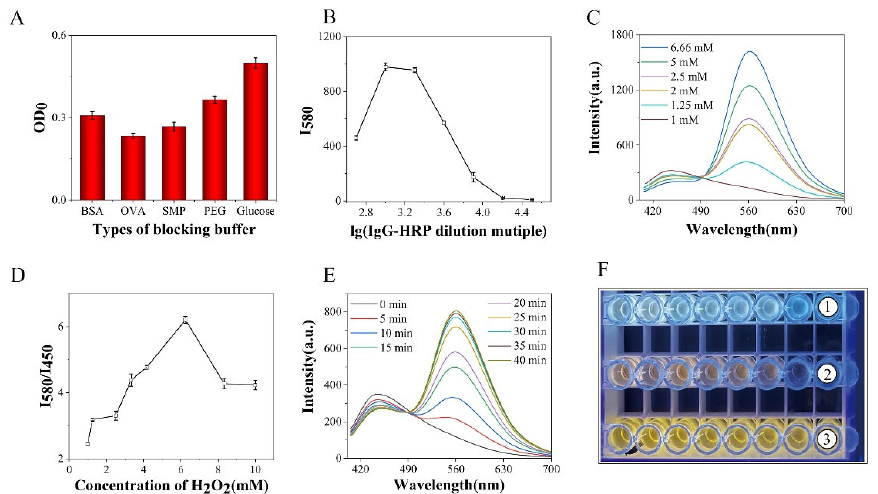
Figure 3. Optimization of the parameters for ratiometric fluorescent immunoassay. ( A ) OD 0 values of different types of blocking buffer (1% BSA, 1% OVA, 5% SMP, 0.5% PEG 2000, 2% glucose). ( B )